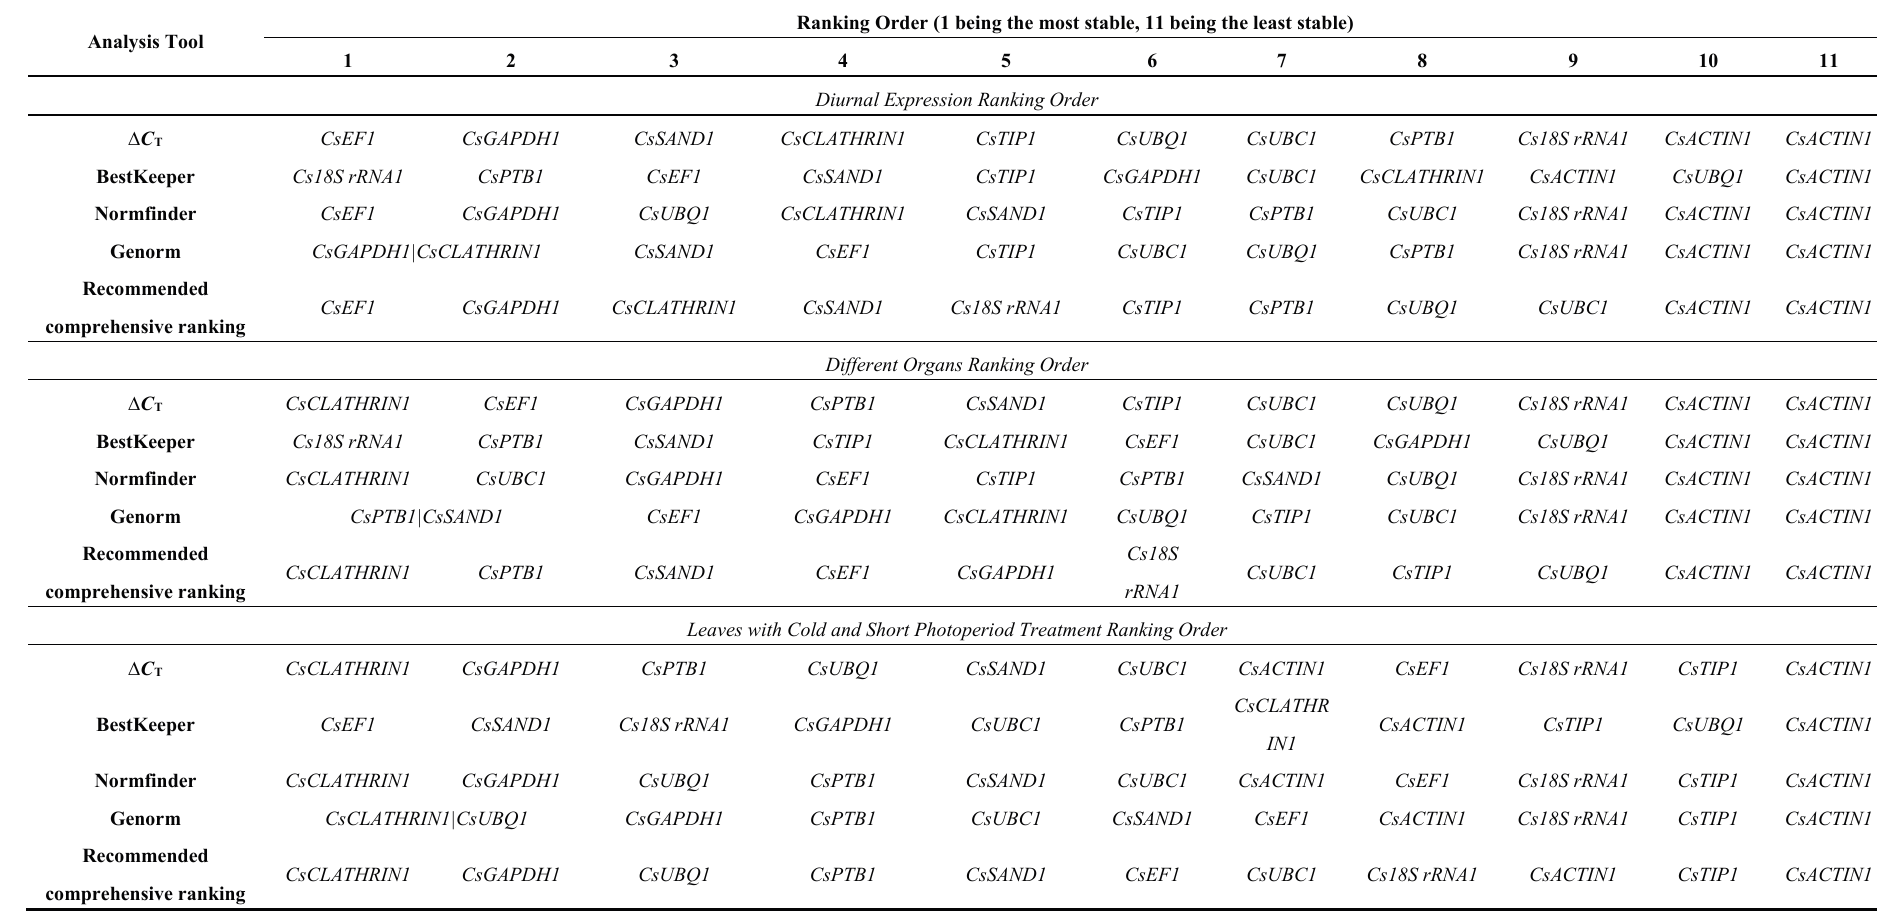
Table 2. Stability ranking of candidate reference